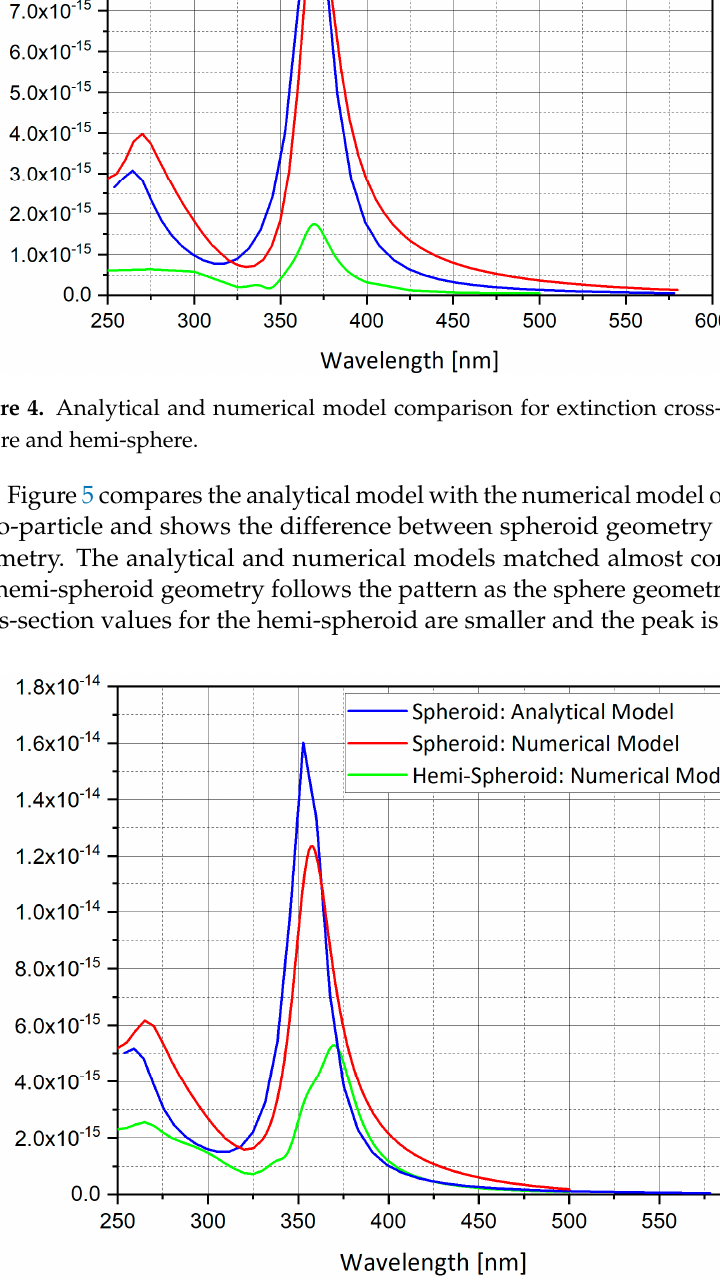
Figure 5. Analytical and numerical model comparison for extinction cross-section of silver (Ag) spheroid and hemi-spheroid.